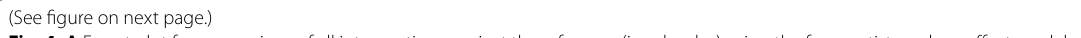
figure on next Fig. 4 A Forest plot for comparison of all interventions against the reference (i.e. placebo) using the frequentist random-effect model network meta-analysis. B Individual study results (for all studies) grouped by treatment comparison. Forest plot was based on random-effects model for network meta-analysis. MD mean difference between active and placebo arms in monthly migraine frequency from baseline to end of =